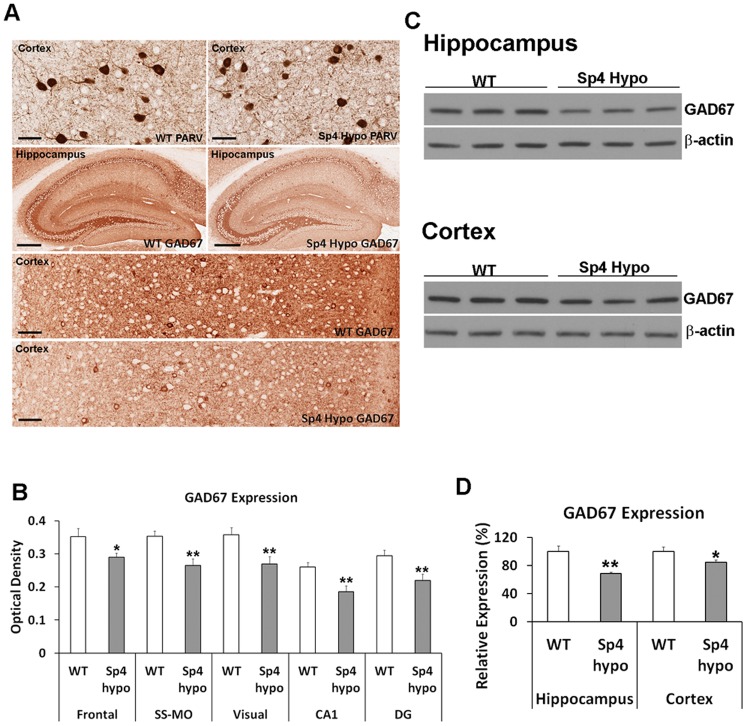
Reduced expression of GAD67 in Sp4 hypomorphic mice.(A) Immunohistochemical staining of parvalbumin (PARV) and GAD67 proteins in both cortex and hippocampus of wildtype (n = 7) and Sp4 hypomorphic (n = 7) mice. To quantify the level of protein expression, the sections were not counter-stained. The “white spots” in sections were nucleus of neuronal cells not stained by the antibodies. No difference was found in parvalbumin staining, scale bar: 25 µm. Reduced expression of GAD67 was readily detected in the hippocampus (scale bar: 250 µm) and cortex (scale bar: 60 µm) of Sp4 hypomorphic mice. (B) Quantification of GAD67 protein expression in immunohistochemical staining of different brain regions (frontal cortex, somatosensory and motor cortex (SS-MO), visual cortex, hippocampal CA1, and hippocampal dentate gyrus (DG)) of wildtype (n = 7) and Sp4 hypomorphic (n = 7) mice. Significant reduction of GAD67 staining was observed in all these regions. (C) Western blot analysis confirmed decreased expression of GAD67 proteins in both hippocampus and cortex of Sp4 hypomorphic mice. Equal amount of proteins were loaded, as shown by β-actin expression. (D) Quantification of GAD67 protein expression in Western blot. Significant reductions of GAD67 proteins were confirmed in Sp4 hypomorphic mice (n = 5) in comparison with wildtype sibling controls (n = 4). (* p<0.05; ** p<0.01).